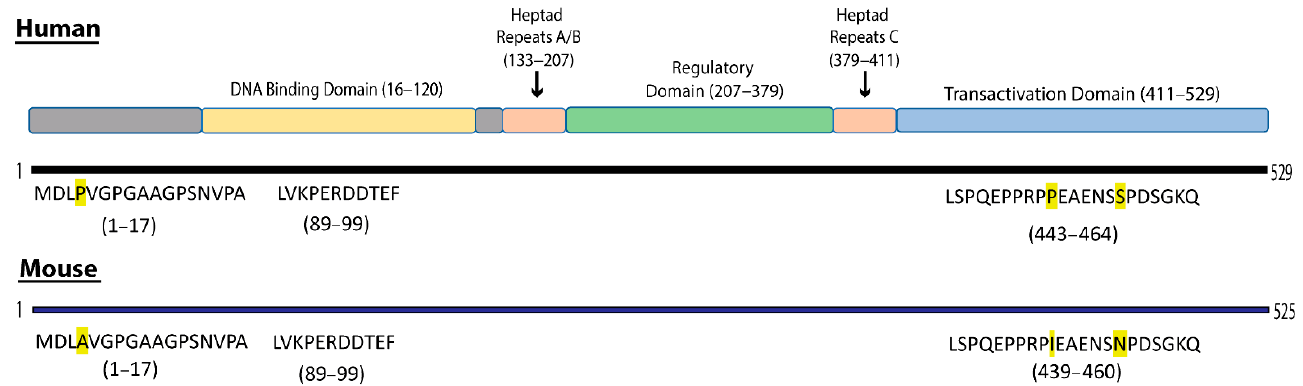
Figure 1. Human HSF1 (HuHSF1) structure contains four main domains: the DNA-binding domain, heptad repeats, the